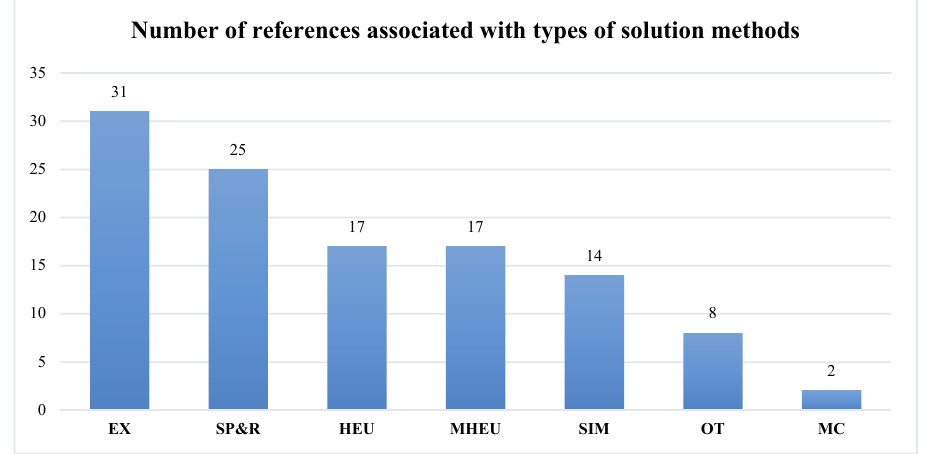
Fig. 6. References by type of solution method